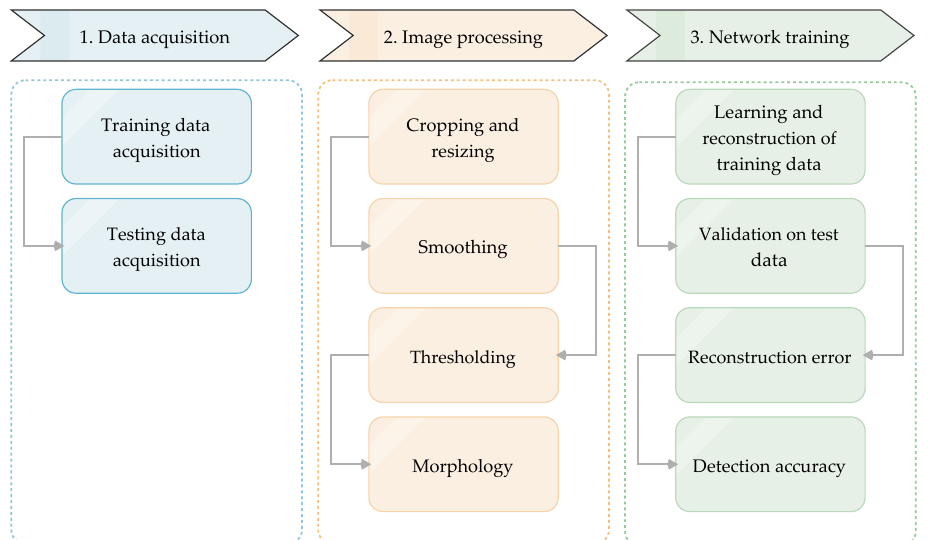
Figure 4. Procedure algorithm.